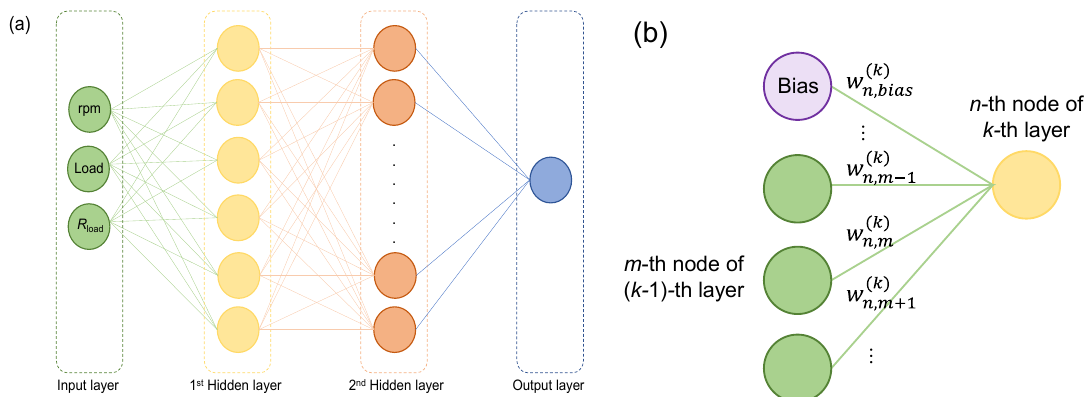
Figure 2. ANN developed in this study: ( a ) basic structure of three-layer multi-perceptron ANN developed in this study, ( b ) expression for weights of each neuron.